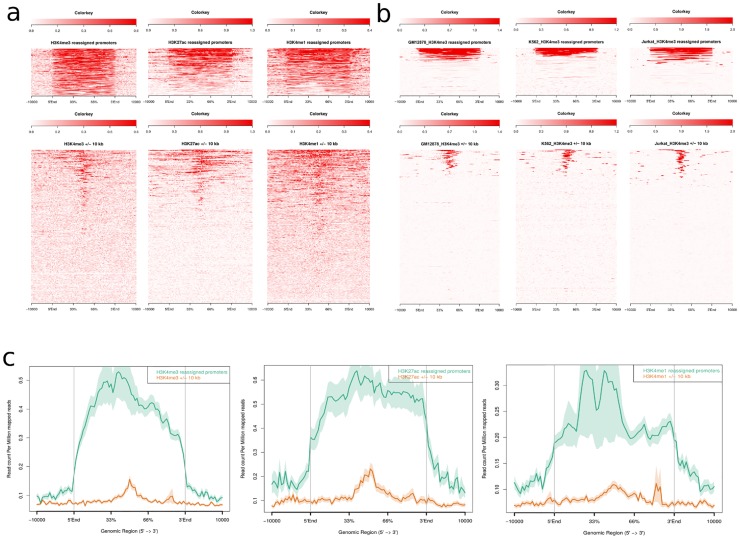
Histone mark ChIP-seq read density plots of candidate t(12;21) active promoters.(a) Heatmaps of H3K4me3, H3K27ac and H3K4me1 ChIP-seq normalized read densities for candidate (bottom, ± 10kb around the 5’ start of vlincRNAs, n = 256) and reassigned (top, n = 79) t(12;21) active vlincRNA promoters. (b) H3K4me3 ChIP-seq normalized read densities in GM12878, K562 and Jurkat cell lines on candidate and reassigned t(12;21) active vlincRNA promoters. (c) ChIP-seq normalized read density plots of the H3K4me3, H3K27ac and H3K4me1 histone marks for candidate and reassigned t(12;21) vlincRNA promoters.